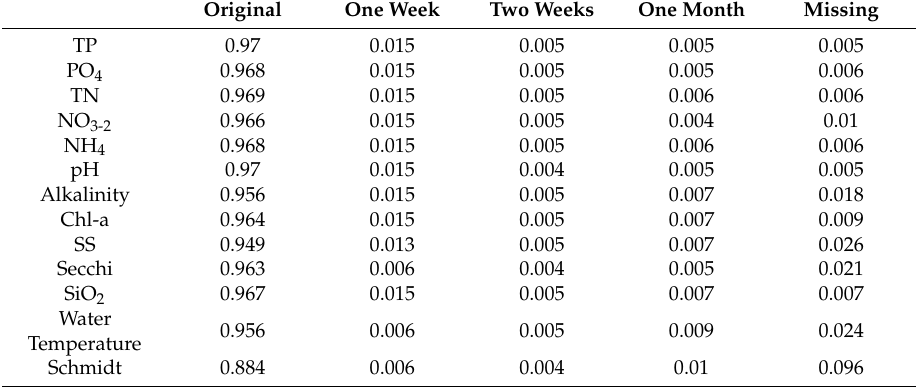
Table A1. Summary of data treatment for missing values in environmental variables. Frequencies of concurrent plankton and environmental samplings (original) and replacement with different averages are given. The lakes included in the analyses are: Bryrup Langsø, Søholm Sø, Hinge Sø,